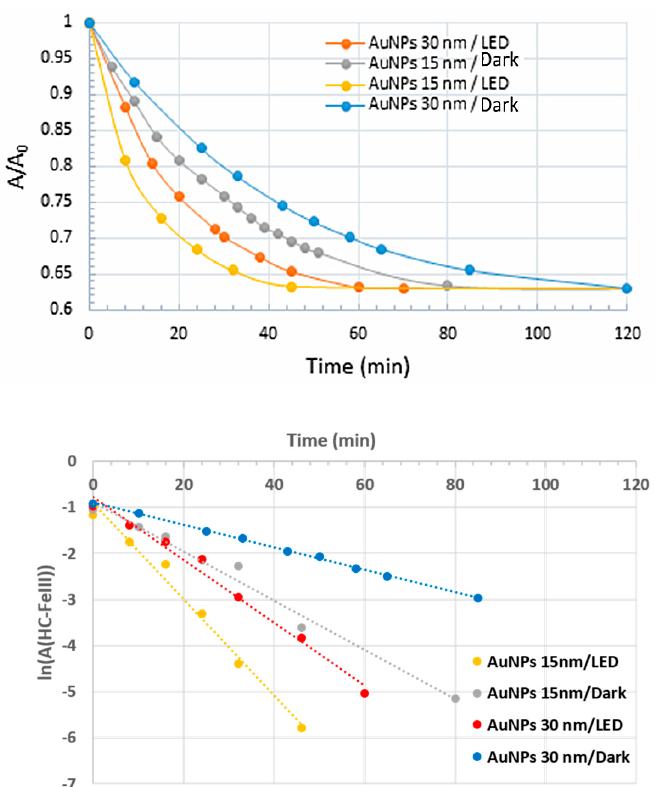
Figure 3. Kinetic traces of the normalized absorbance at 420 nm ( top ) and logarithm of the absorbance of HC-FeIII at 420 nm ( bottom ) for the reduction of HC-FeIII in a deaerated aqueous solutions containing 5 × 10 − 4 M sodium thiosulfate and 5 × 10 − 4 M potassium hexacyanoferrate in the presence of 15 nm or 30 nm Au-NPs@citrate in the dark or under LEDs (irradiation at 520 nm).